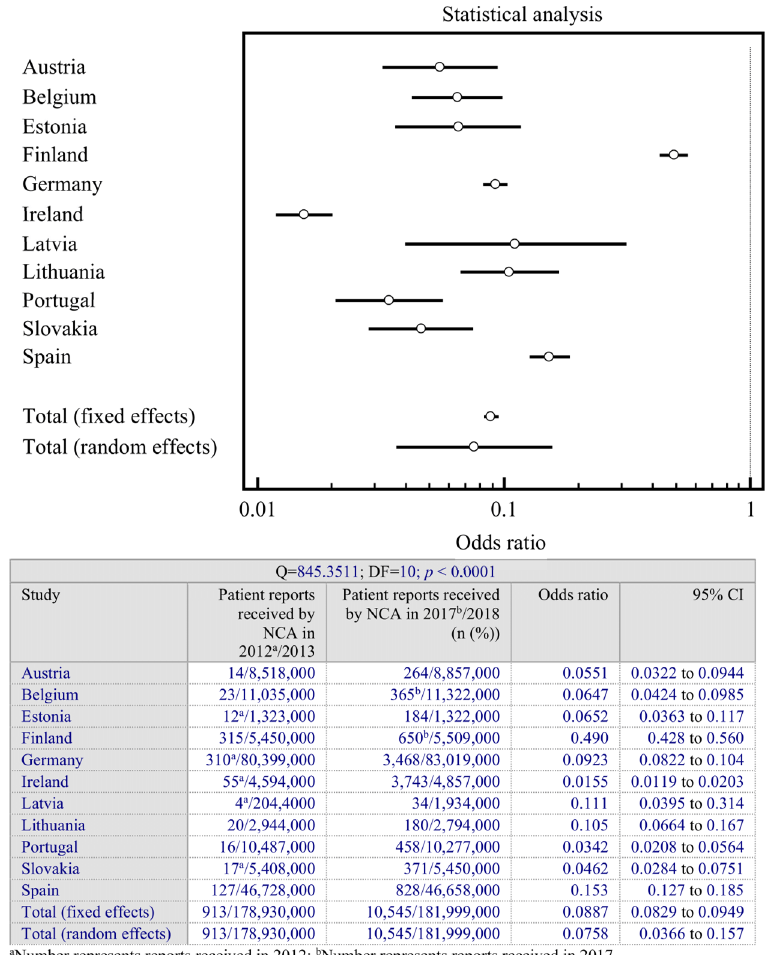
Figure 1. The changes in the number of ADR reports received individually by each country and